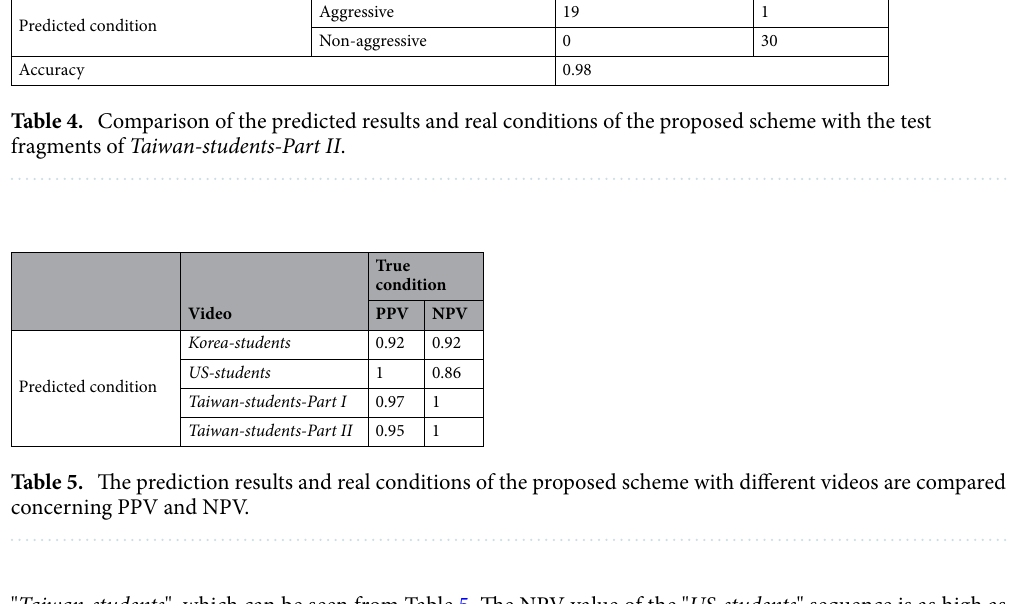
Taiwan-students-Part II